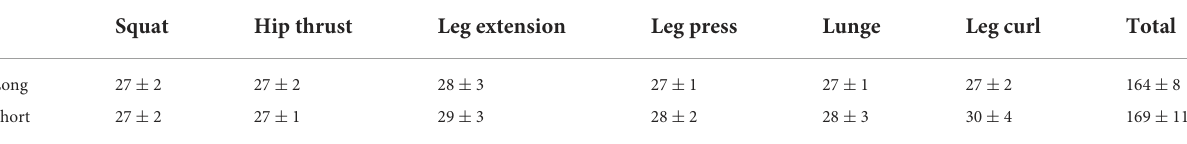
TABLE 3 Accumulated number of repetitions for three sets using ∼ 9RM loading for each exercise in the long and short sessions (mean ± standard deviation). Squat Hip thrust Leg extension Leg press Lunge Leg curl Total Long 27 2 ±